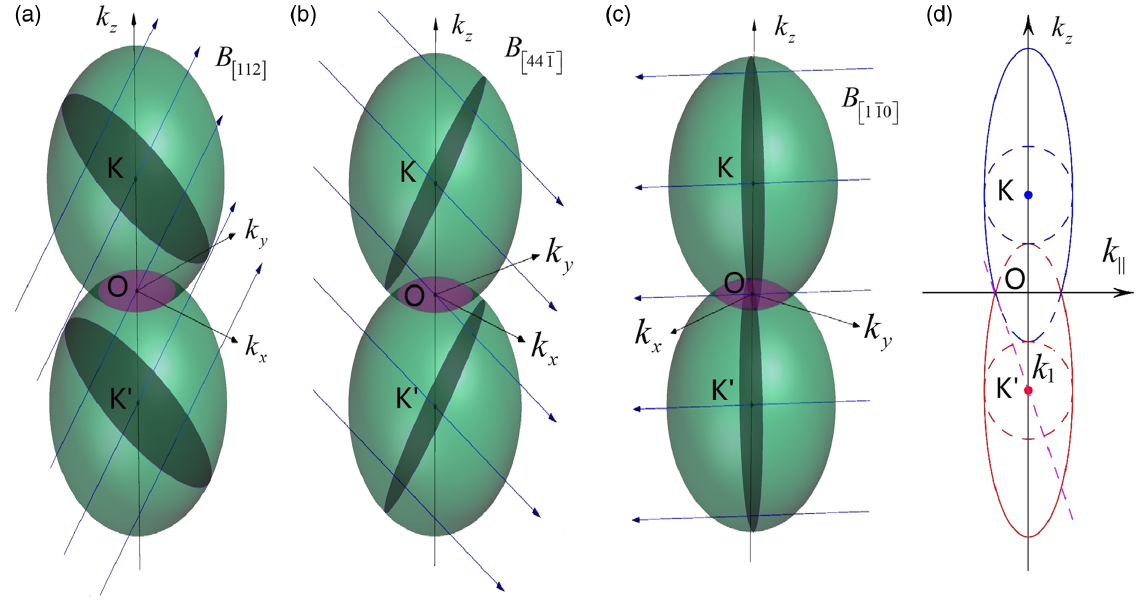
FIG. 5. Theoretical analysis of 3D nested anisotropic Fermi surface in Cd 3 As 2 . Panels (a) – (c) show the largest cross section of Fermi surface versus the magnetic field orientation. The Fermi surface is two nested anisotropic ellipsoids. Panel (d) shows the schematic plot of the Fermi surface for B ½ 1¯ 1 0 (cid:2) direction with an overlapping region. The figures are not drawn to